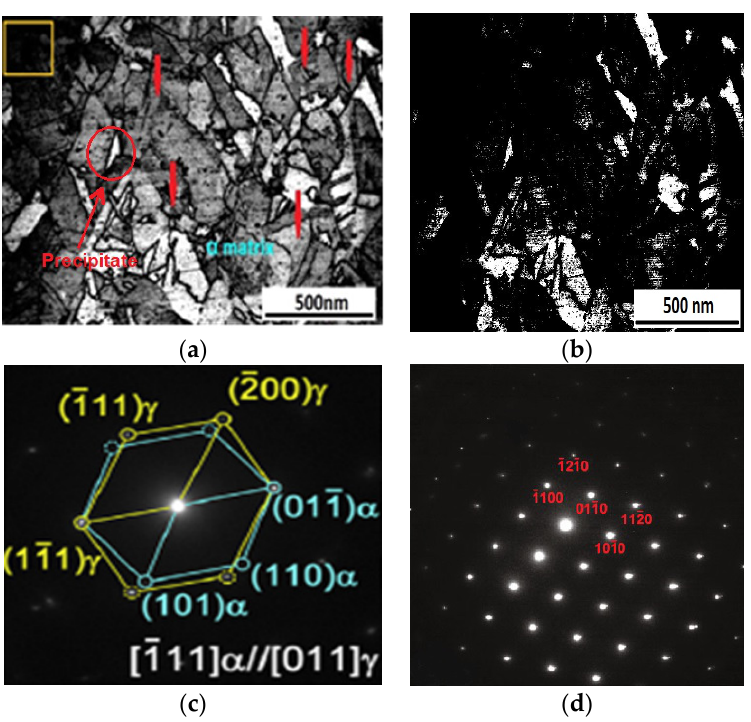
Figure 14. TEM images Aged maraging steel sample ( a ) bright field ( b ) dark field and ( c ) corresponding SAED pattern of intermetallic compound, ( d ) secondary diffraction pattern (SAED) pattern of matrix.